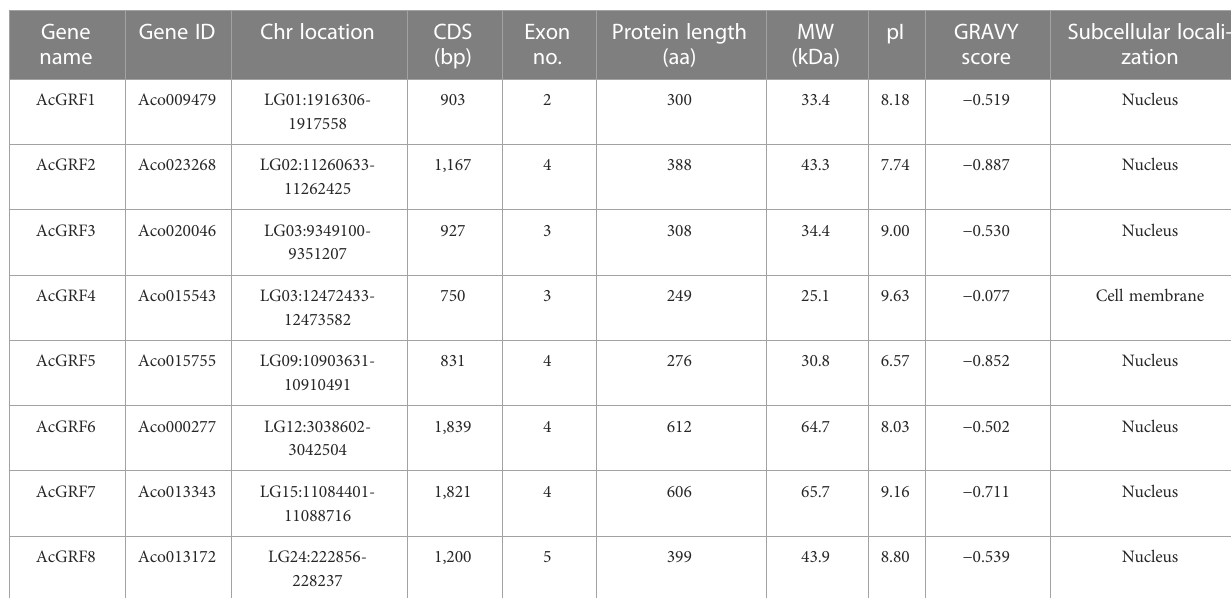
TABLE 1 Characteristics of